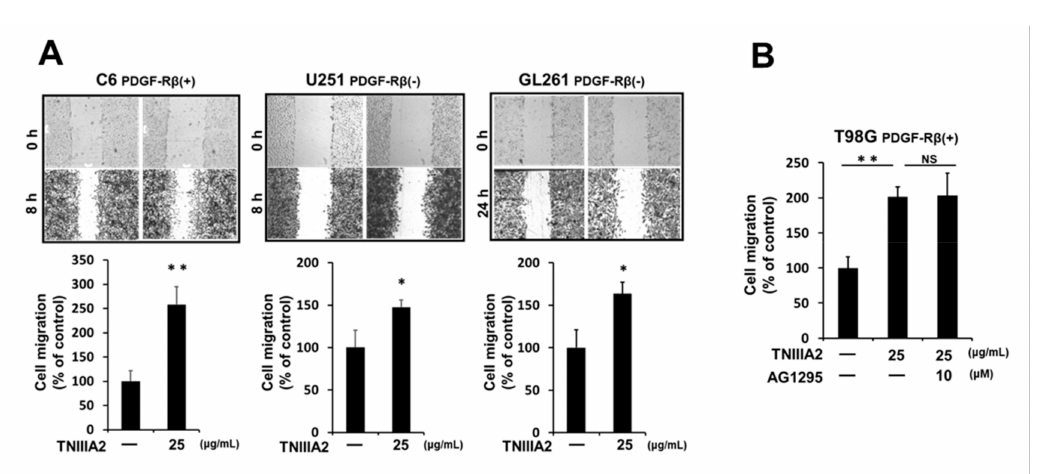
Figure 4. TNIIIA2 promotes cell migration of GBM cells in a PDGF-R-independent manner. ( A ) E ff ect of TNIIIA2 on cell migration on the fibronectin substrate were evaluated in three GBM cell lines, namely, C6, U251, and GL261, by the wound healing assay, as described in the Materials and Methods section. ( B ) E ff ect of AG1295, a PDGF-R kinase inhibitor, on TNIIIA2-enhanced T98G cell migration was examined as above. Data represent the mean ± standard deviation of triplicate determinations, * p < 0.05, ** p < 0.01; NS not significant.